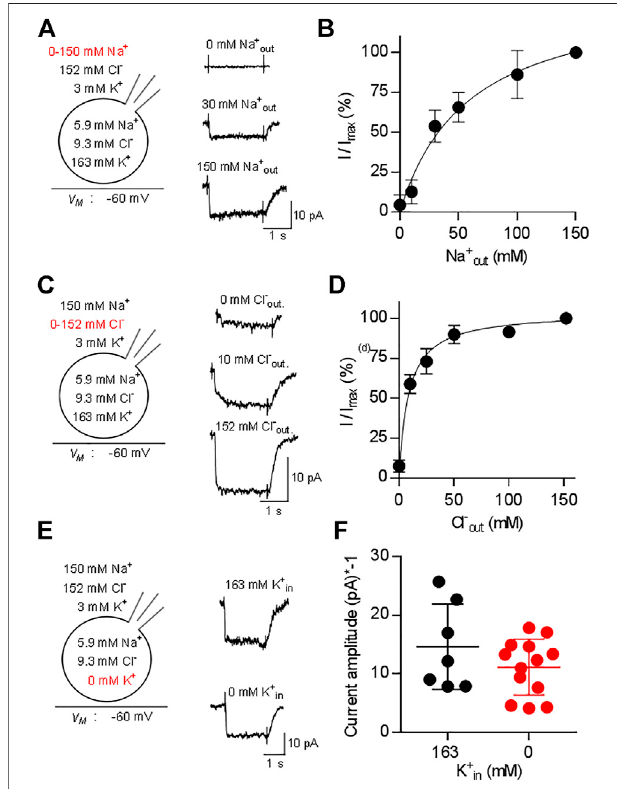
FIGURE 3 | Dependence of currents through CRT-1 on physiologic ion gradients. The schematic representation on the left hand side of each row illustrates the recording condition, i.e. the membrane potential, the extracellular and the intracellular ion concentrations employed in panels (A – F) ; the experimental variation in ionic composition is indicated in red. Panels A, C, E show the original recordings of currents through CRT-1, which were elicited by superfusion of HK293 cells transiently expressing CRT-1 with 250 µM creatine in the presence of 0 mM, 30 and 150 mM extracellular Na + (A) , or in the presence of 0 mM, 10 and 152 mM extracellular Cl − (C) or in the presence 163 mM and absence of intracellular K + (E) . Panels B and D show the dependence of creatine-induced current amplitudes on the concentration of extracellular Na + panel (B) and Cl − (D) (n = 15) during superfusion with 250 µM creatine: currents were recorded at the indicated ion concentrations asinpanelsAandC;thecurrentamplitude(I)wasnormalizedtotheamplitude ofthesteadystatecurrentmeasuredatthehighestconcentrationofNa + orCl − (I max ) to account for variation in transporter expression and cell size. The solid line were drawn by fi tting the data to the Hill equation (B) or to a rectangular hyperbola (D) . Inpanel B, the datapoints weremore adequately described by the Hill equation than by the equation for a rectangular hyperbola (F-test, p = 0.012), providing an EC 50 estimate for sodium of 37.1 ± 4.2 µM and a Hill coef fi cient of 1.41 ± 0.17 for sodium. In panel D, the Hill equation did not provideabetter fi tthantherectangularhyperbola(F-test, p =0.082).TheEC 50 estimate for Cl − was 8.6 ± 0.9 µM. Data are means ± S.D., n = 12 and 14 in panels B and D respectively. Panel F compares the amplitudes of currents, which were elicited by 250 µM creatine in the presence of 163 mM cytosolic K + (n=7)orinabsenceofintracellularK + (n=13)andrecordedasinpanel (E)